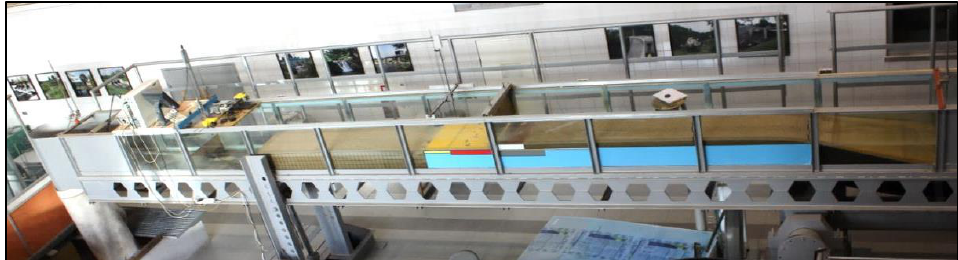
Figure 4. Experimental channel scheme—side view.